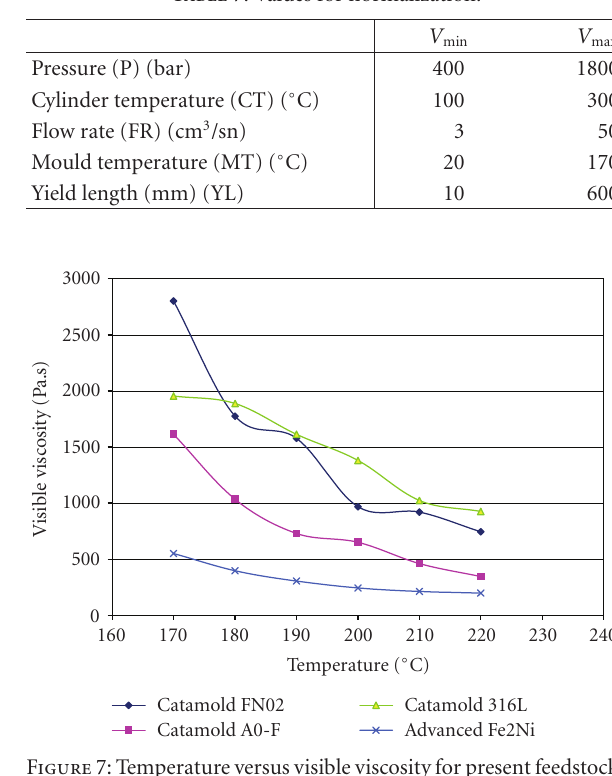
Table 7: Values for normalization.